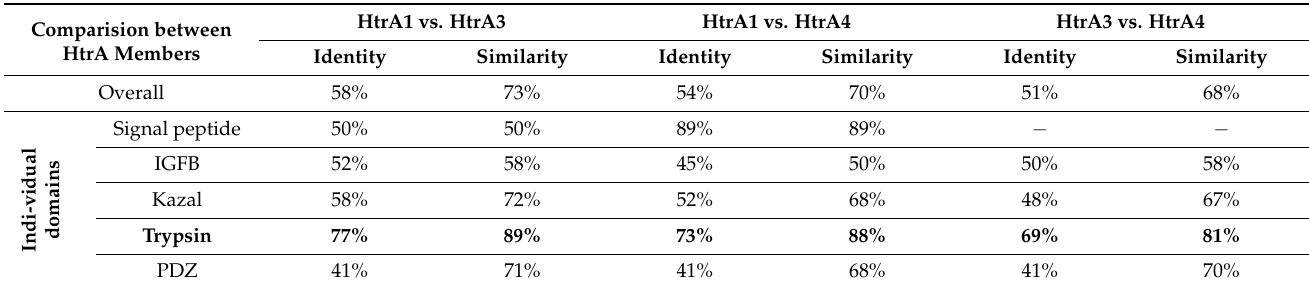
Table 2. Comparison of amino acid sequences of human HtrA1, 3 and 4